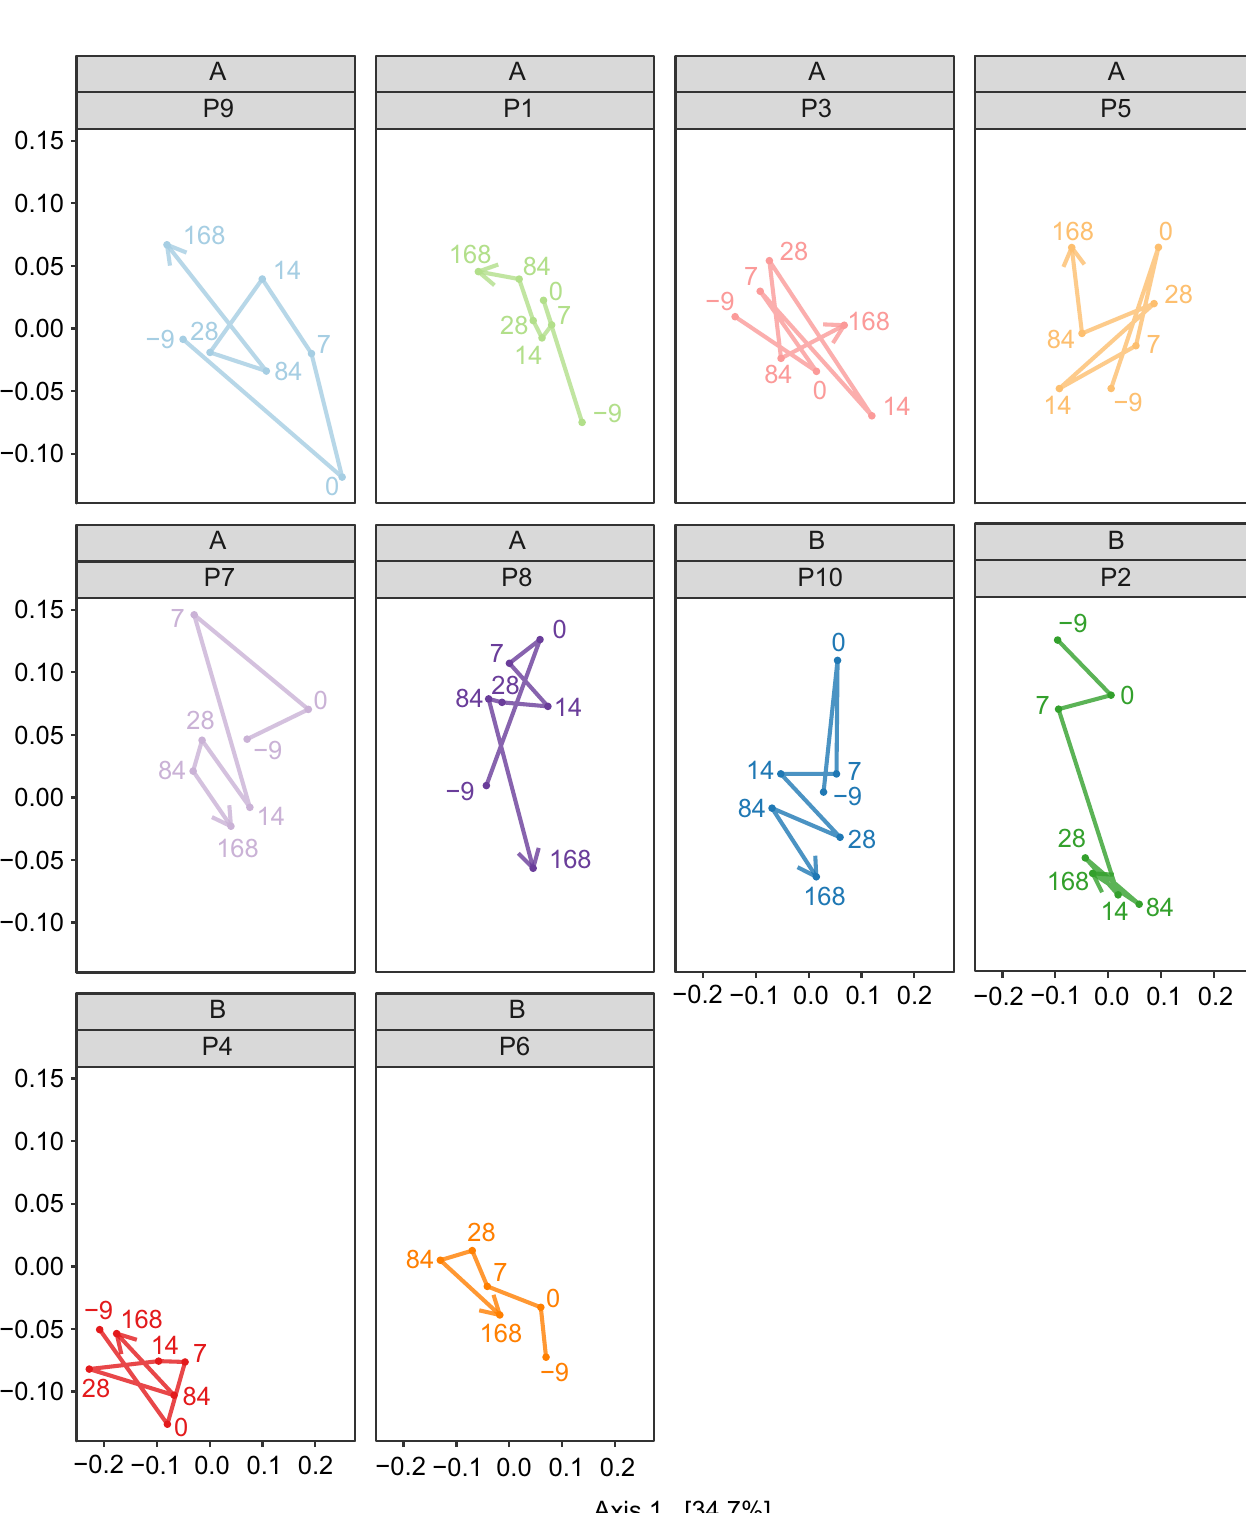
Figure 8. Weighted UniFrac PCoA of 16S rRNA gene-based prokaryotic community composition of faecal microbiota from individual FFW horses (i.e., P1 to P10). Samples from before (d –9) and after FMT (d 0, d 7, d 14, d 28, d 84 and d 168) are shown (i.e., seven samples for each FFW horse). The time course through the samples is indicated by a line, the direction of which is indicated by the arrowhead. The identity of the donor animal used to prepare the inoculant for each FFW horse is indicated above the FFW horse